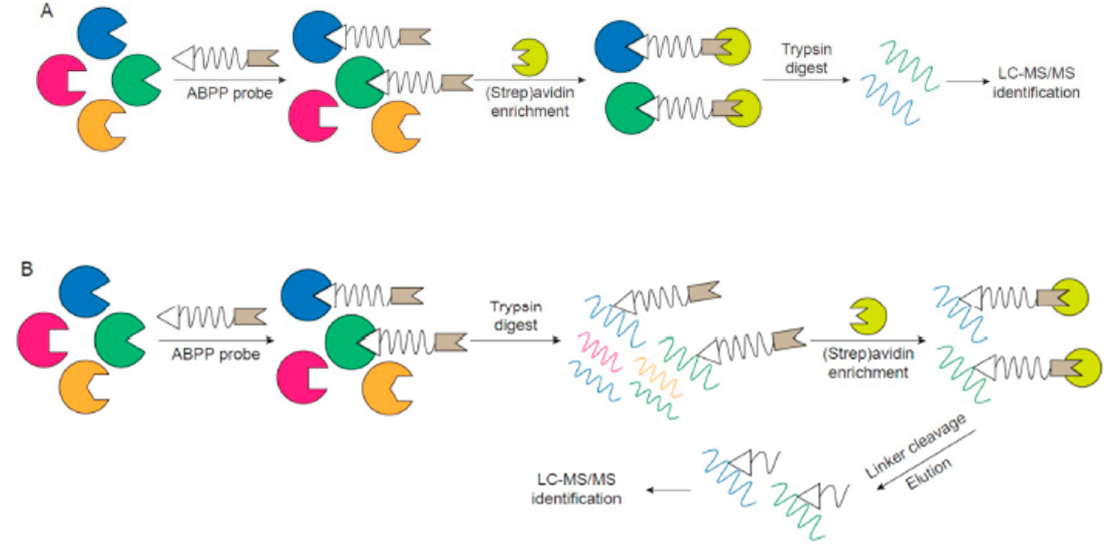
Figure 1. Overview of activity-based proteomic profiling (ABPP) followed by SDS-PAGE analysis. ( A ) General design of an ABPP probe containing a reactive group, a linker region and a fluorescent or affinity tag. ( B ) Example reaction of a fluorescent ABPP probe with a sample containing enzymes followed by SDS-PAGE separation and detection of labeled proteins by fluorescence gel scanning.